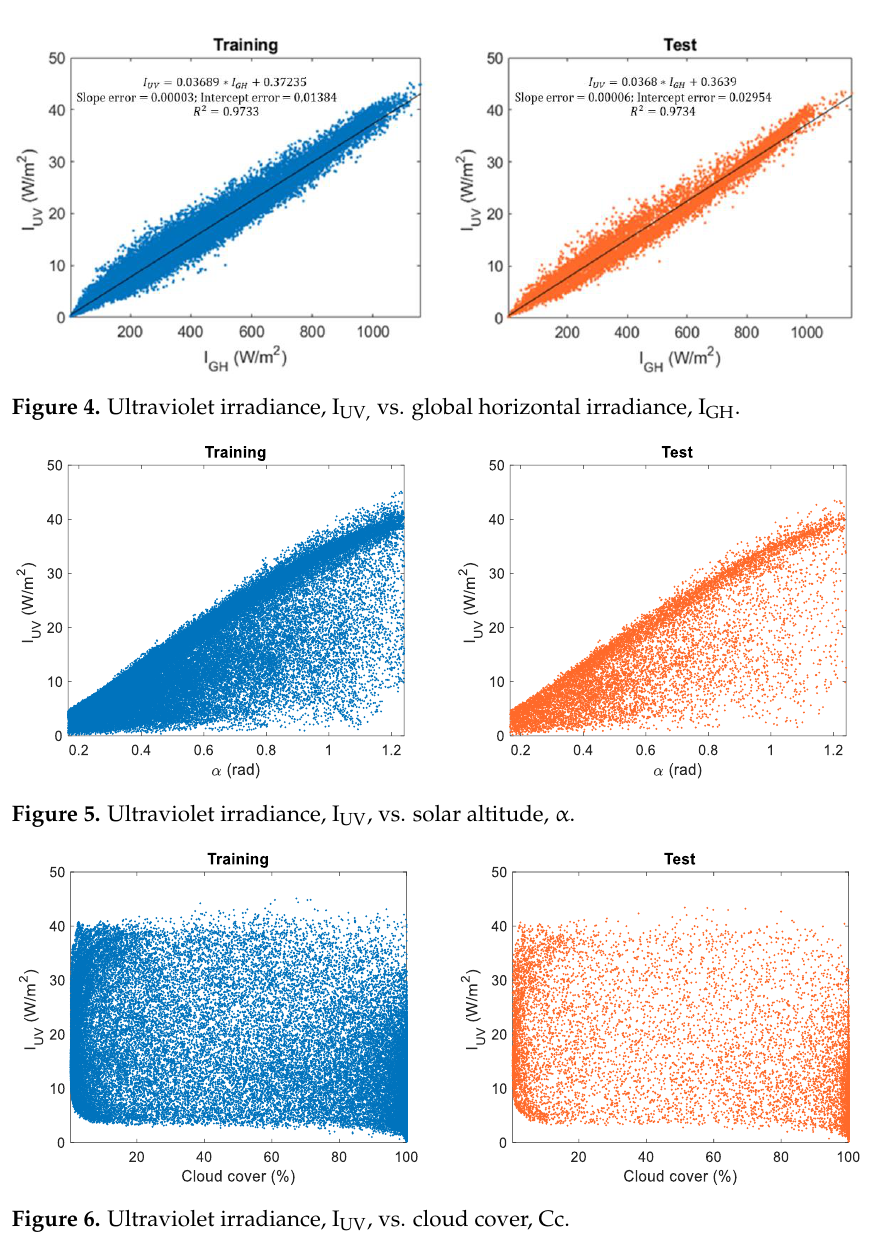
Figure 6. Ultraviolet irradiance, I UV , vs. cloud cover, Cc .